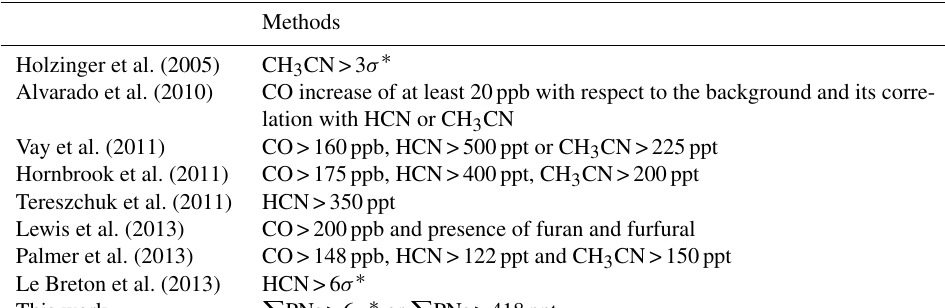
Table 2. Methods to identify BB